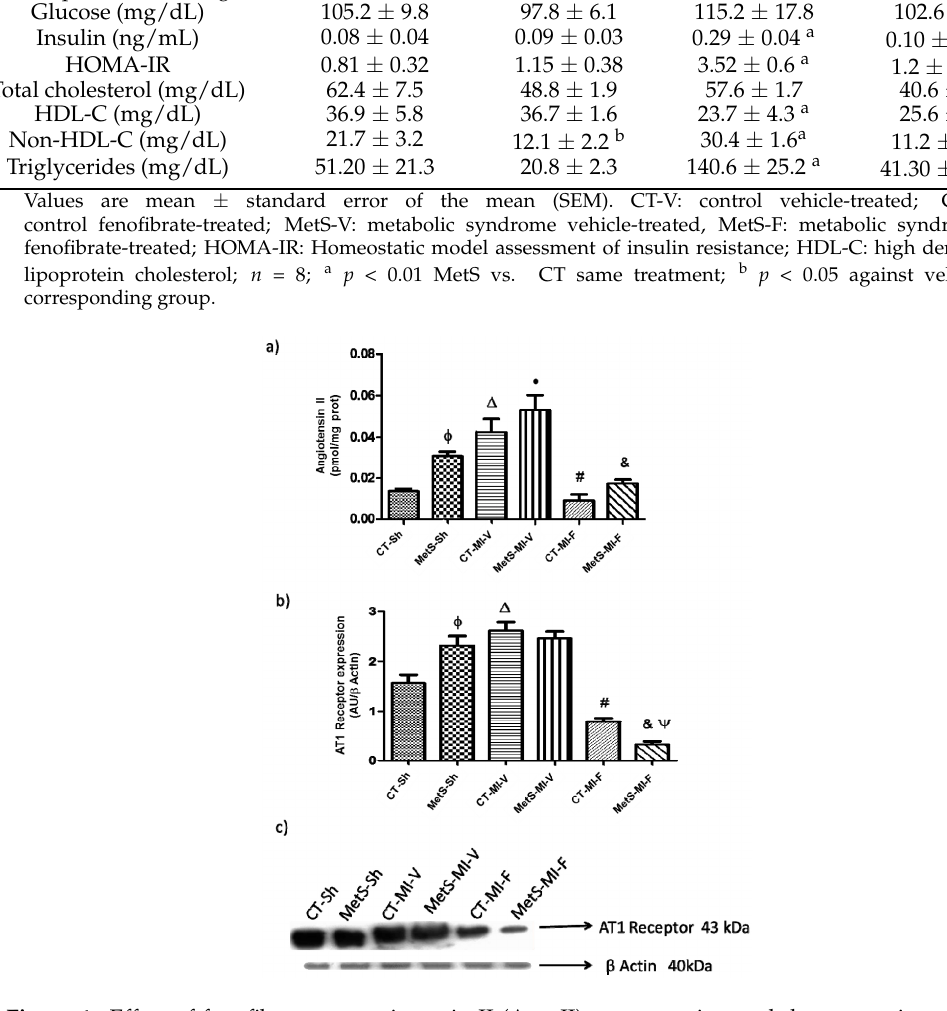
Figure 1. Effect of fenofibrate on angiotensin II (Ang II) concentration and the expression of AT1 receptor. ( a ) Ang II concentration was evaluated in the left ventricles from control (CT) and metabolic syndrome (MetS) rats subjected to sham- (Sh-) or myocardial infarction (MI) and treated two weeks with either vehicle (V) or fenofibrate (F); ( b ) AT1 protein expression, Arbitrary Units (AU); ( c ) Representative western blot analysis. Data represent mean ± SEM ( n = 5 per group). φ p < 0.05 vs. CT-Sh; ∆ p < 0.05 vs. CT-Sh; • p < 0.05 vs. MetS-Sh; # p < 0.05 vs. CT-MI-V; & p < 0.05 vs. MetS-MI-V; Ψ p < 0.05 vs. CT-MI-F. Analysis of